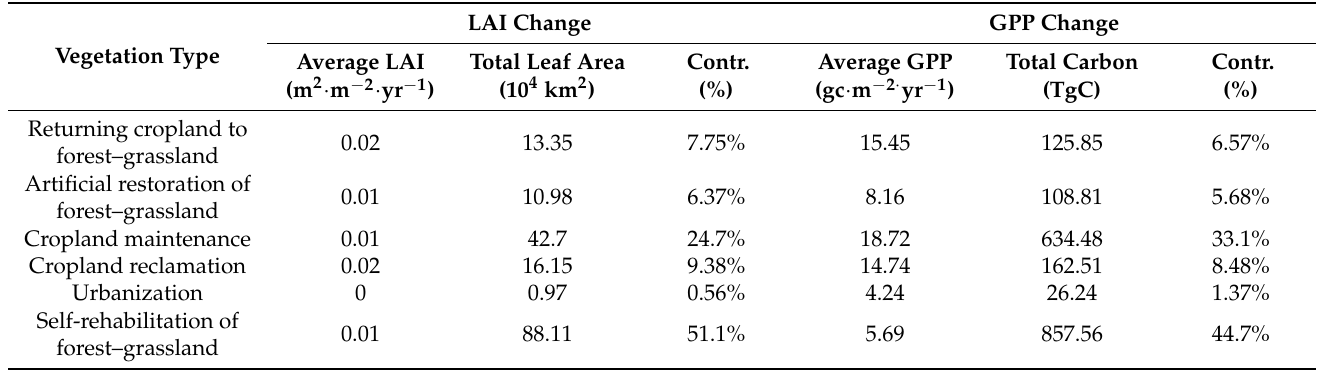
Table 4. Annual mean and total changes in the LAI and GPP in the major vegetation transfer areas.